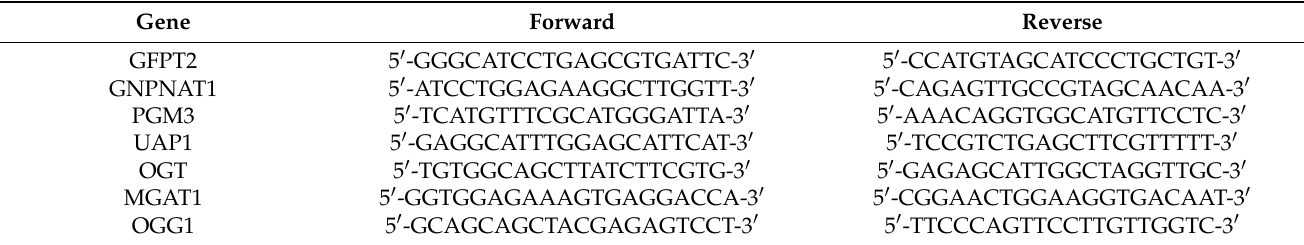
Table 1. Quantitative RT-PCR